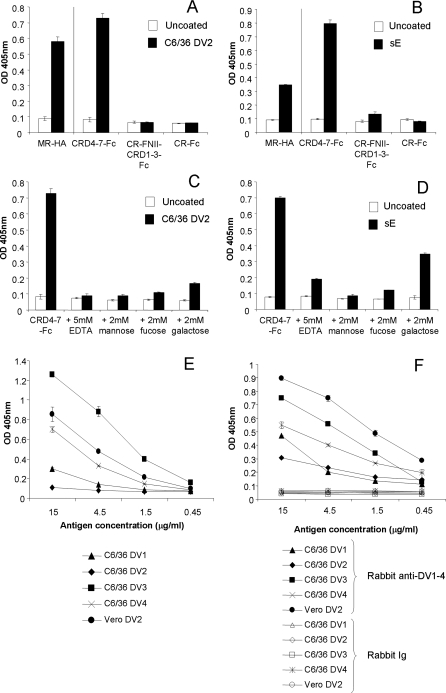
MR Binding to DV Is Mediated by the CRD4–7(A) Binding of MR extracellular domain (MR-HA) and chimeric MR fusion protein constructs to mosquito cell–derived (C6/36) NGC strain DV2 and (B) soluble E protein (sE) produced in a human cell line, detected by ELISA. Closed bars, DV antigen; open bars, uncoated wells. The MR-HA protein was detected with an anti-murine MR antibody (MR5D3). Binding of the Fc fusion proteins to the DV/sE was detected with an anti-Fc antibody. (C) Inhibition of CRD4–7-Fc binding to mosquito cell–derived semi-purified DV2 and (D) sE, detected by ELISA as above. (E) Binding of CRD4–7-Fc to all four serotypes of DV, detected with an anti-Fc antibody. Strains examined were mosquito cell (C6/36)–derived virus of DV1 (Hawaii), DV2 (NGC), DV3 (H-87) and DV4 (H-241), and Vero cell–grown DV2 (16681). Differential binding to the serotypes may reflect coating levels, as indicated by (F) binding of rabbit anti-DV1–4 antibody. Normal rabbit immunoglobulin (RIg) was included as a control and both were detected with an anti-rabbit antibody. The low levels of CRD4–7-Fc binding to C6/36-grown DV2 in this panel reflect a shorter development time than in the other panels. Data are expressed as mean and SD of triplicate wells. Representative data from two to five independent experiments are shown. Recombinant fusion proteins contain the cysteine-rich (CR) domain, fibronectin type-II (FNII) domain, and various carbohydrate-recognition domains (CRD) of the MR.